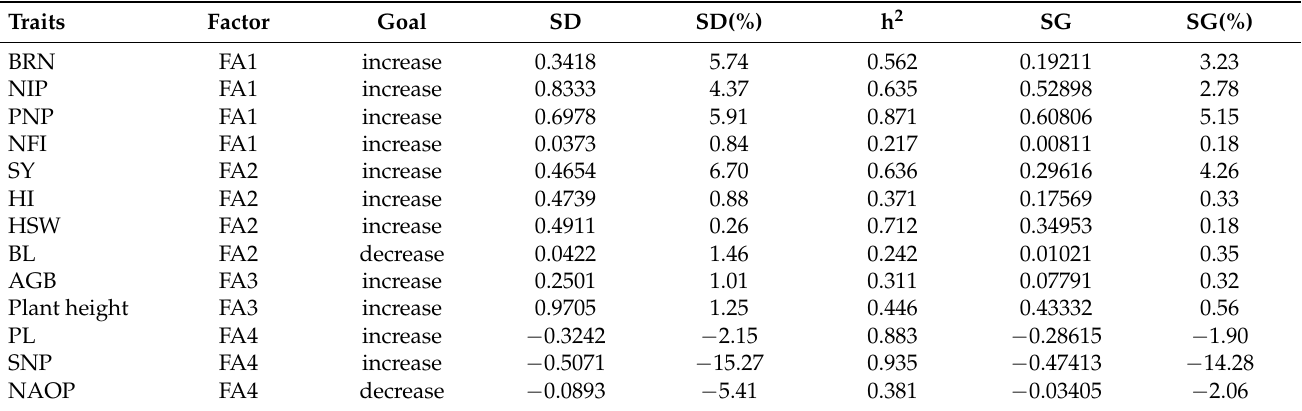
Table 4. Faba bean traits, selection differential (SD), heritability (h 2 ), and selection gain (SG) for the WAASBY index in 15 faba bean landraces.